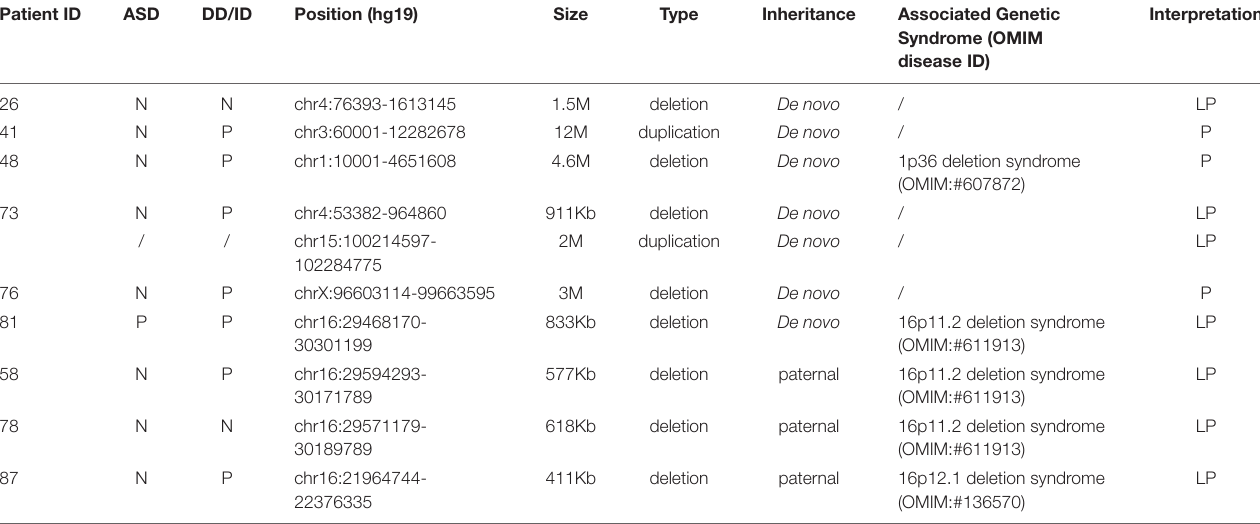
TABLE 4 | Pathogenic/likely pathogenic CNVs identified by WES and CNVseq in forty-one pedigrees. Patient ID